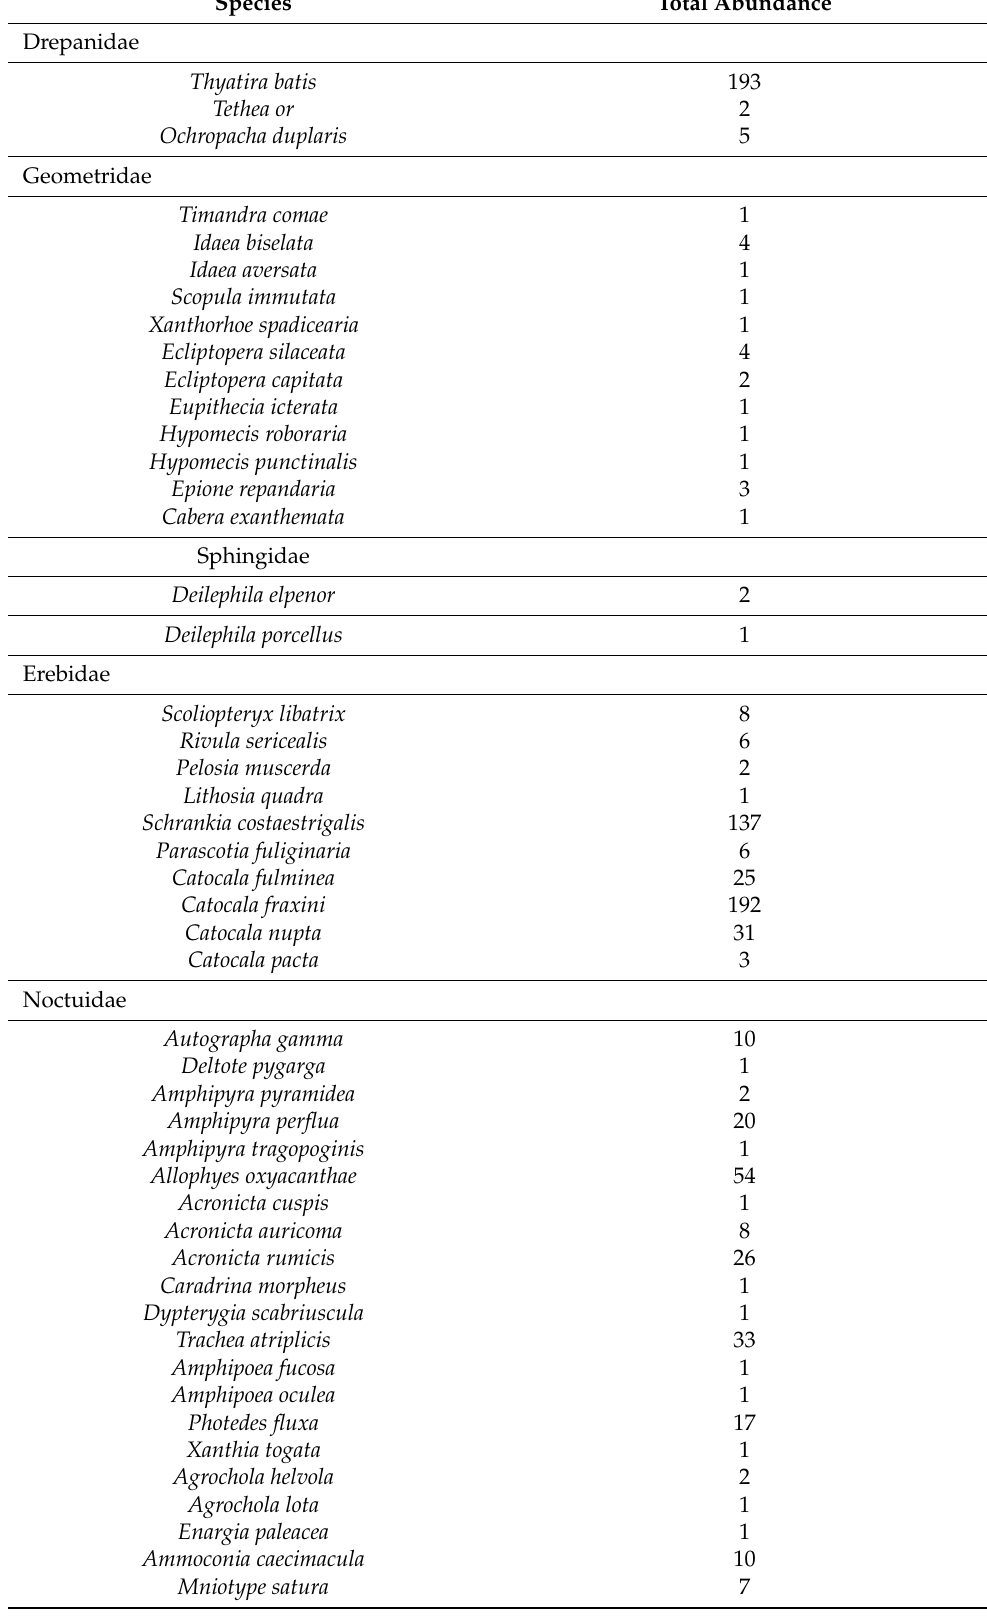
Table 2. Macroheterocera recorded in the bait trap samples. Systematics and nomenclature follows